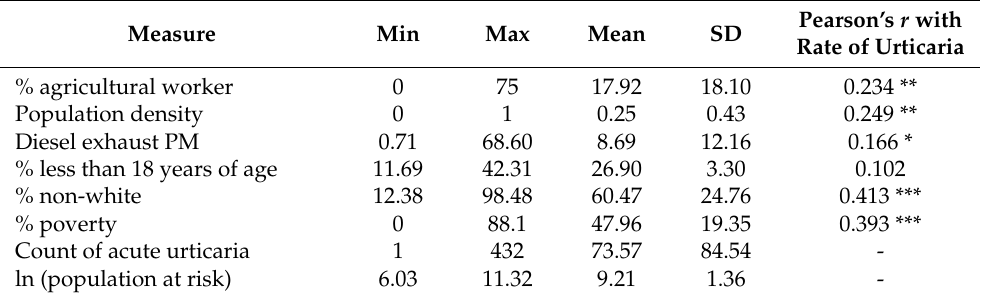
Table 4. Descriptive statistics of zip code-level ( n = 201) measures for counts of acute urticaria, San Joaquin Valley,